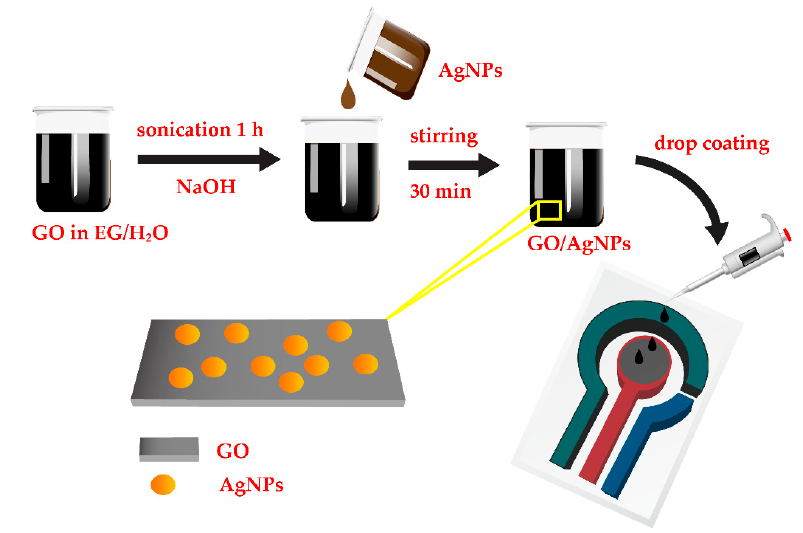
Figure 2. Schematic diagram of preparation of AgNPs / graphene oxide (GO) nanocomposite and fabrication of AgNPs / GO / SPE (screen-printed silver electrode) sensor for Na + detection.